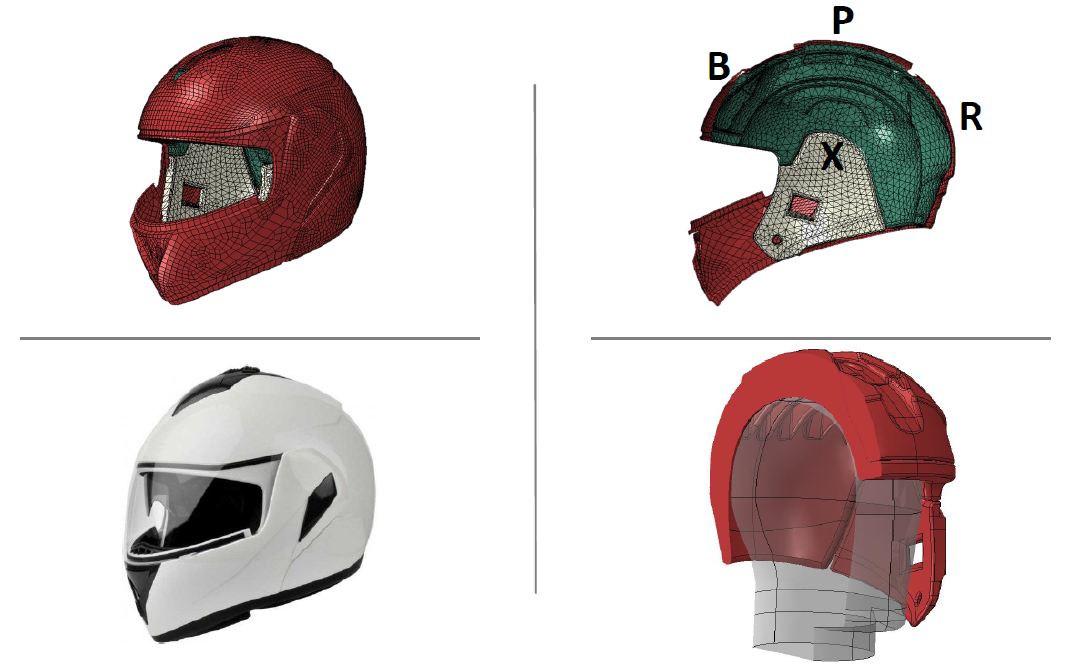
Figure 1. Certified motorcycle helmet, developed FE helmet model, and